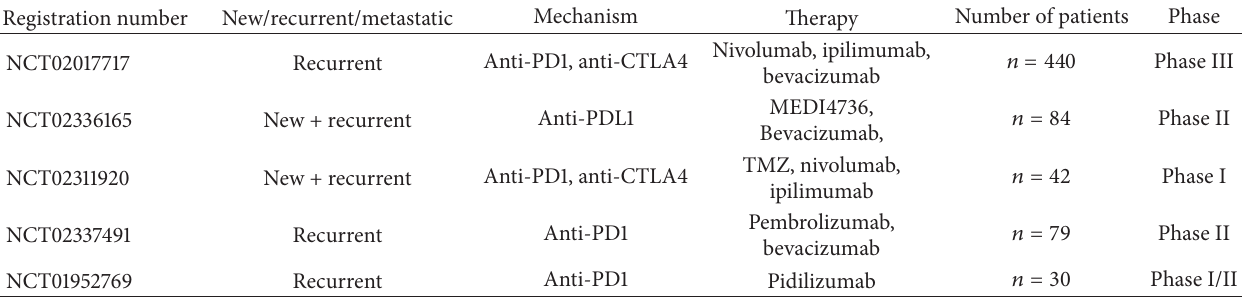
Table 3: Representative clinical trials of immune checkpoint blockade in